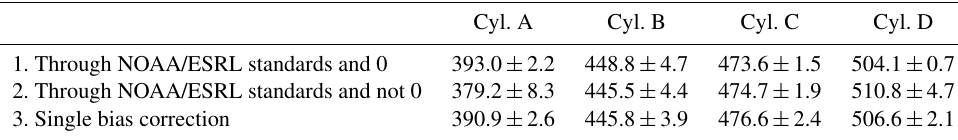
Table 2. COS calibration values for our real-air working standards as obtained from three different calibration approaches: (1) with response from the two NOAA/ESRL calibration standards and a zero point, (2) with the two NOAA/ESRL calibration standards and the curve not forced through a zero point and (3) using a single bias correction. The NOAA/ESRL calibration standards have COS concentrations 447.8 and 486.6ppt. The calibration measurement was repeated three times; results are shown as the average over the three measurements and uncertainties indicate the standard deviation over the three